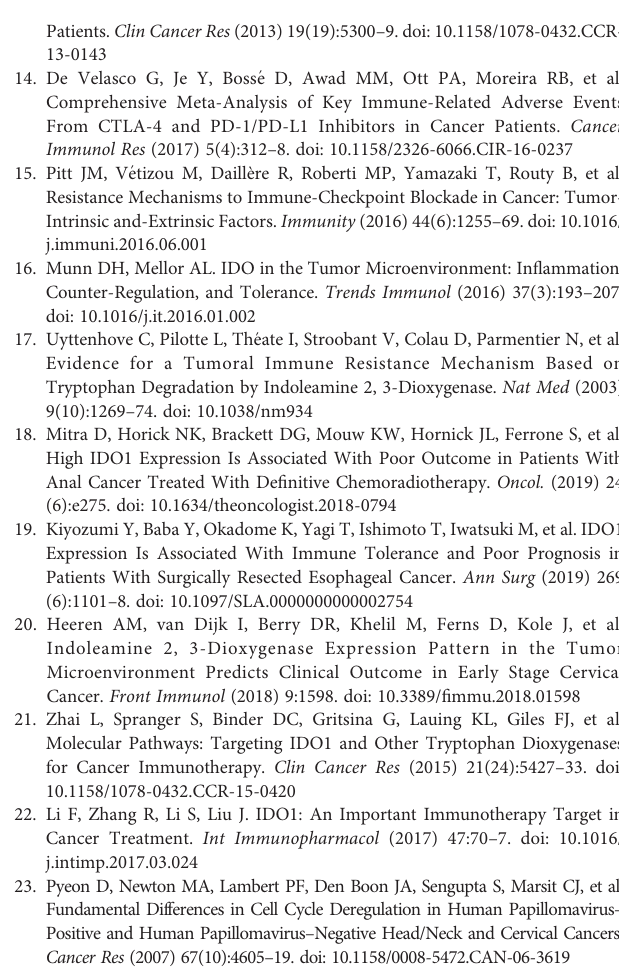
Supplementary Figure 1 | Relationship between CD8+ T-cell in fi ltration and prognosis of CESC via different algorithm. (A) CD8+ T-cell in fi ltration level and CESC prognosis based on xCELL algorithm; (B) CD8+ in fi ltration level and CESC prognosis based on QUANTISEQ algorithm; (C) CD8+ effector memory in fi ltration level and CESC prognosis based on xCELL algorithm. T-cell in fi ltration level and CESC prognosis. Supplementary Table 1 | Genes in Venn